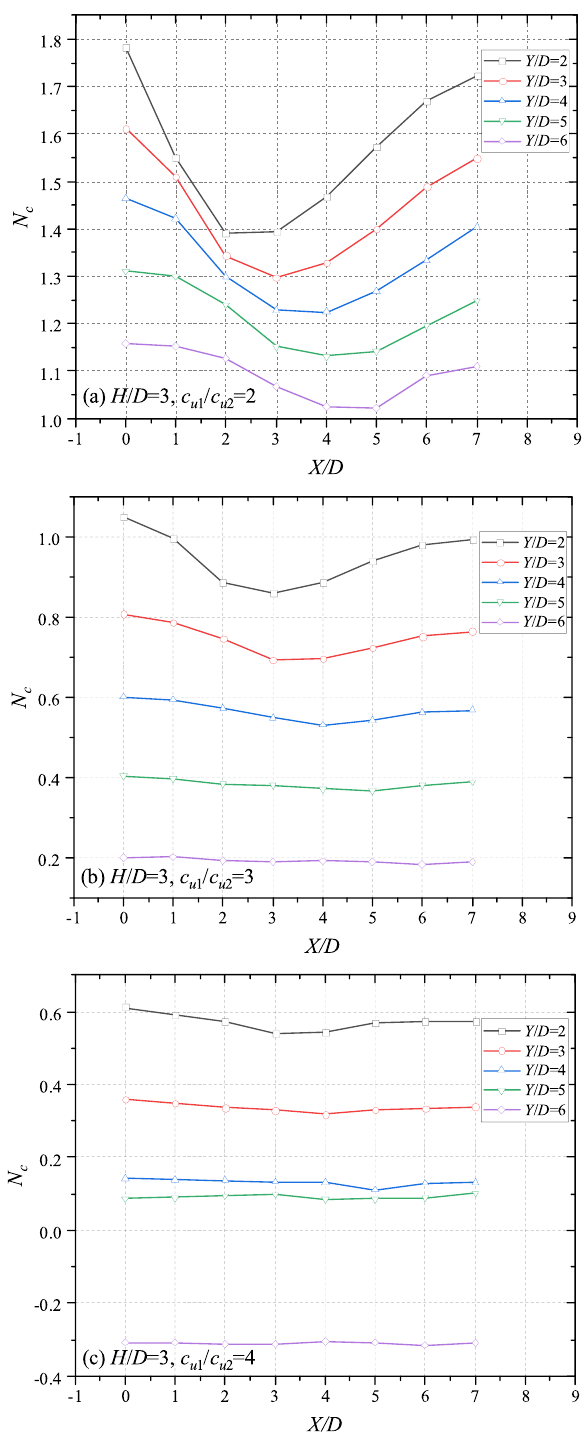
Figure 8. Variation of N c with different X / D and Y / D for ( a ) H / D = 3, c u1 / c u2 = 2; ( b ) H / D = 3, c u1 / c u2 = 3 and ( c ) H / D = 3, c u1 / c u2 =